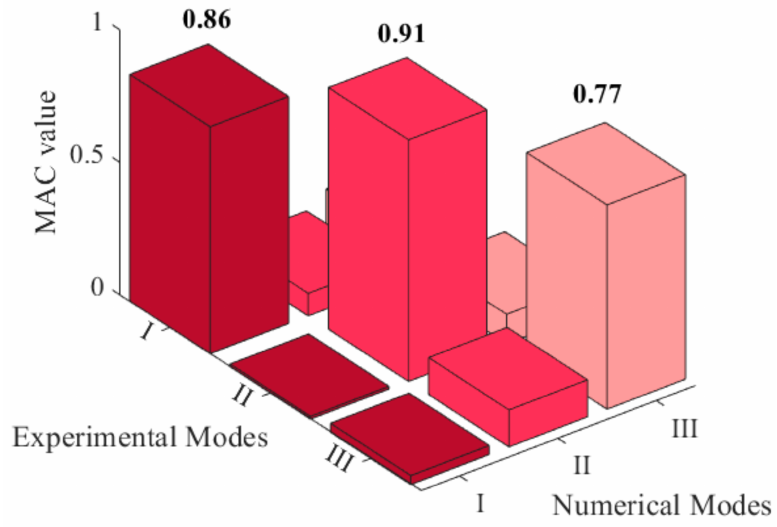
Figure 14. MAC representation between experimental and numerical modes.